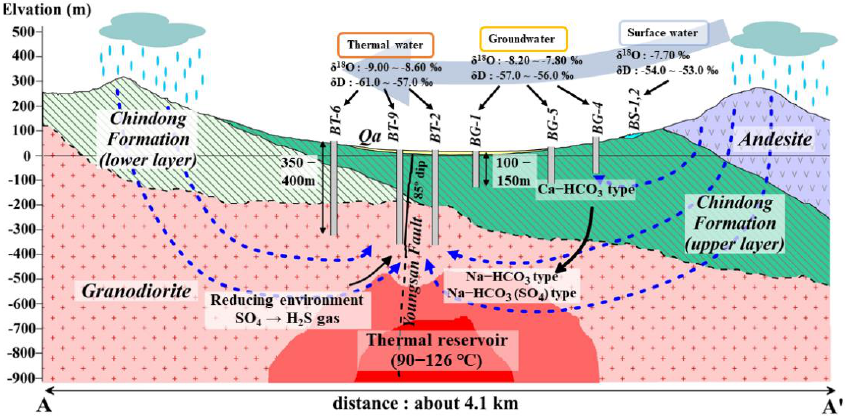
Figure 11. Schematic cross − section of the conceptual, model for a groundwater flow